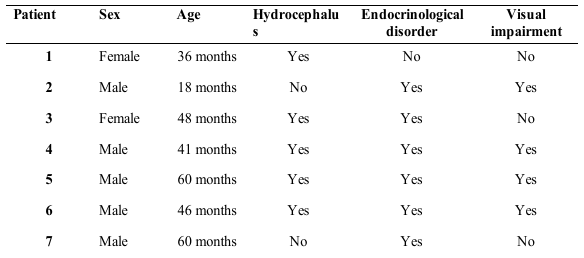
Table 1 - General characteristics and main clinical manifestations of 07 children with adamantinomatous craniopharyngioma with predominant and 01 year after the end of chemotherapy with interferon-α in 06 children